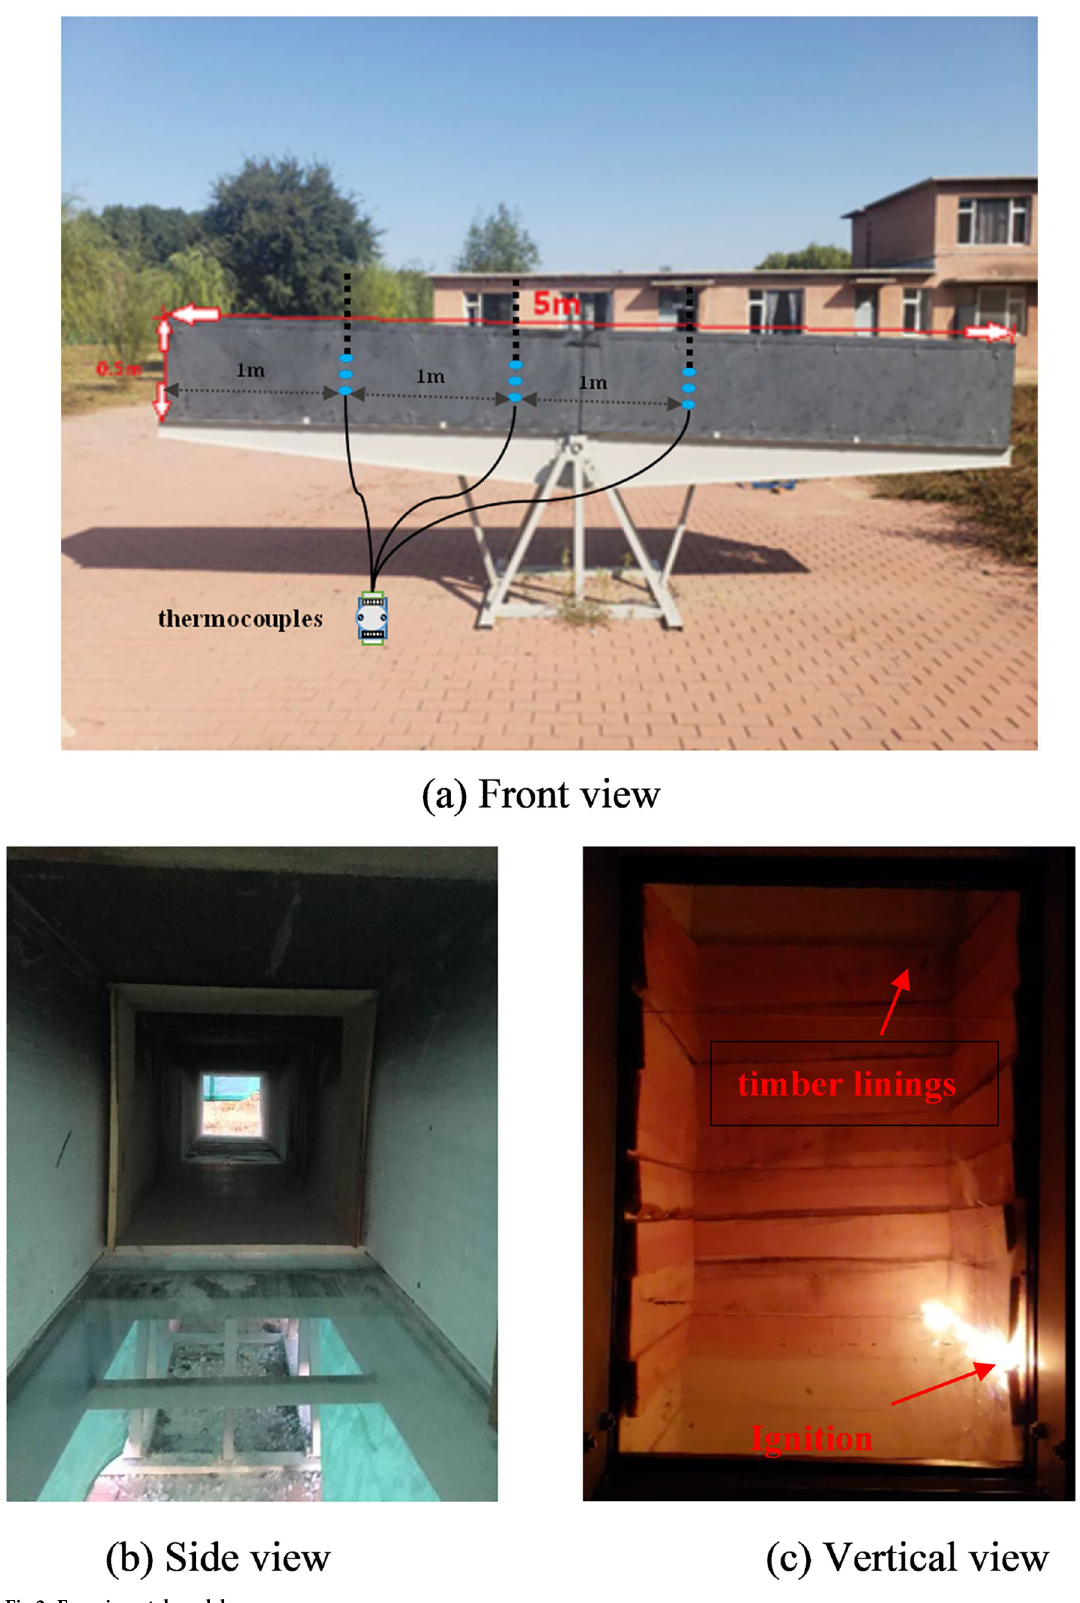
Fig 2. Experimental model. https://doi.org/10.1371/journal.pone.0260655.g002 PLOS ONE | https://doi.org/10.1371/journal.pone.0260655 December2,